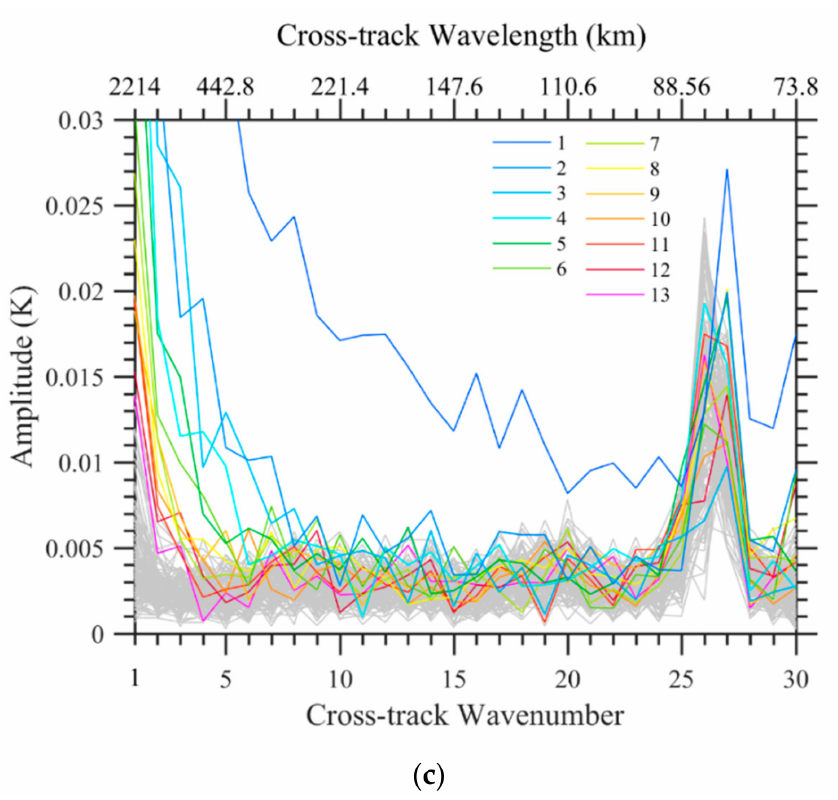
Figure 6. Variations of amplitudes with respect to the along-track wavenumbers for the cross-track wavenumbers 1–13 (color curves) and 14–150 (gray curves) over ( a ) area A, ( b ) area B, and ( c ) area